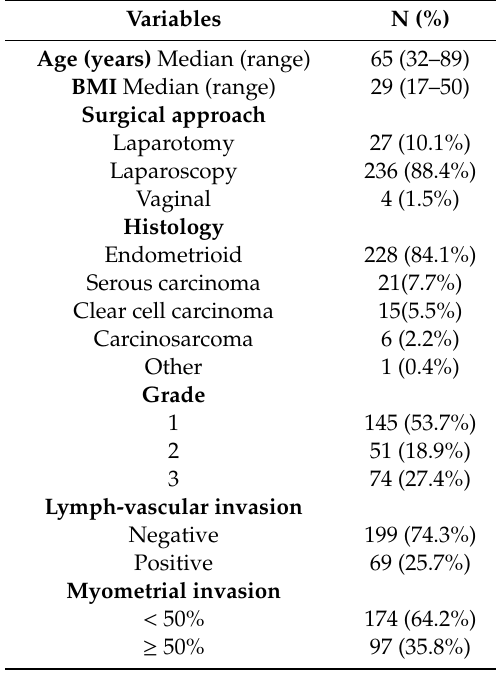
Table 1. Patients and tumor characteristics ( n =